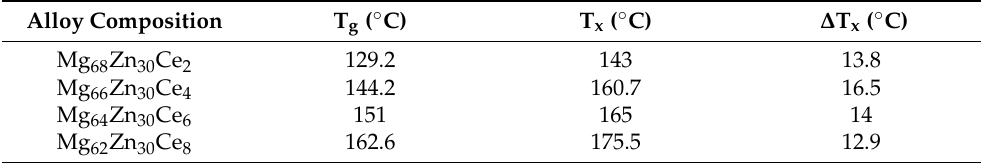
Table 1. Thermodynamic parameters of the Mg 70 − x Zn 30 Ce x (x = 2, 4, 6, and 8) amorphous alloys. Alloy Composition